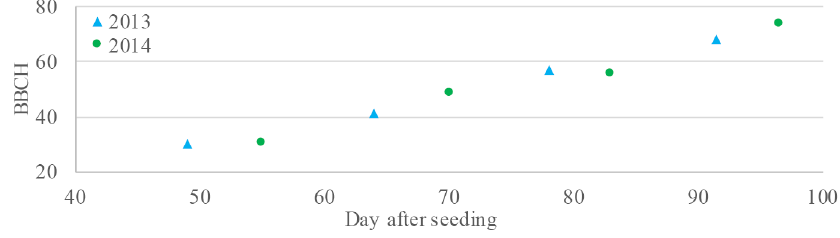
Figure 2. Campaign-wise averaged codes for the developmental steps (BBCH).